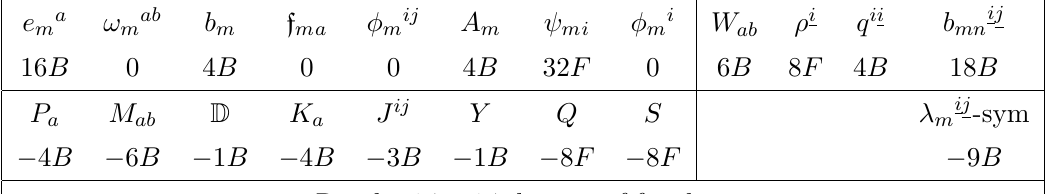
Table 3 . Degrees of freedom and symmetries of the hyper-dilaton Weyl multiplet. Row one gives all the fields in the multiplet. Row two gives the number of independent components of these fields — composite connections are counted with zero degrees of freedom. Row three gives the gauge symmetries. Note that the parameter λ mij describes the vector symmetry associated with the gauge two-forms b mnij with field strength three-forms h mnpij and ˜ H aij . Row four gives the number of gauge degrees of freedom to be subtracted when counting the total degrees of freedom. Row five gives the resulting number of degrees of